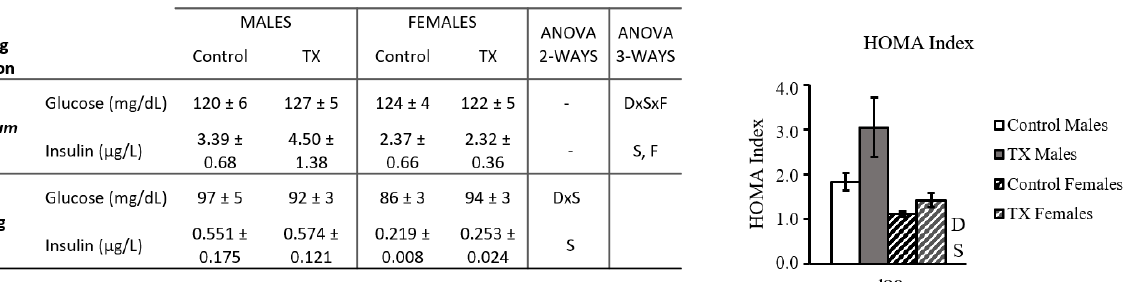
Figure 6. Long-term offspring glucose and insulin characterization. Insulin and glucose levels are presented in the table and HOMA index in the graph to the side. Data are mean ± SEM ( n = 8). Statistics: two-way ANOVA was performed to study the effect of maternal diet and sex. Then, a three-way ANOVA was carried out to also study the effect of feeding conditions: D, the effect of maternal TX diet; S, sex effect; F, feeding conditions effect. Threshold significance was set at p ≤ 0.05.